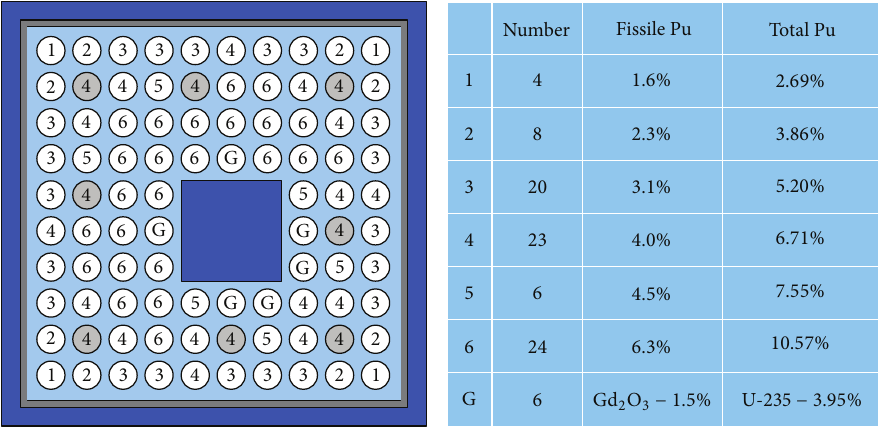
Figure 2: A modern 10 × 10 BWR fuel assembly design.